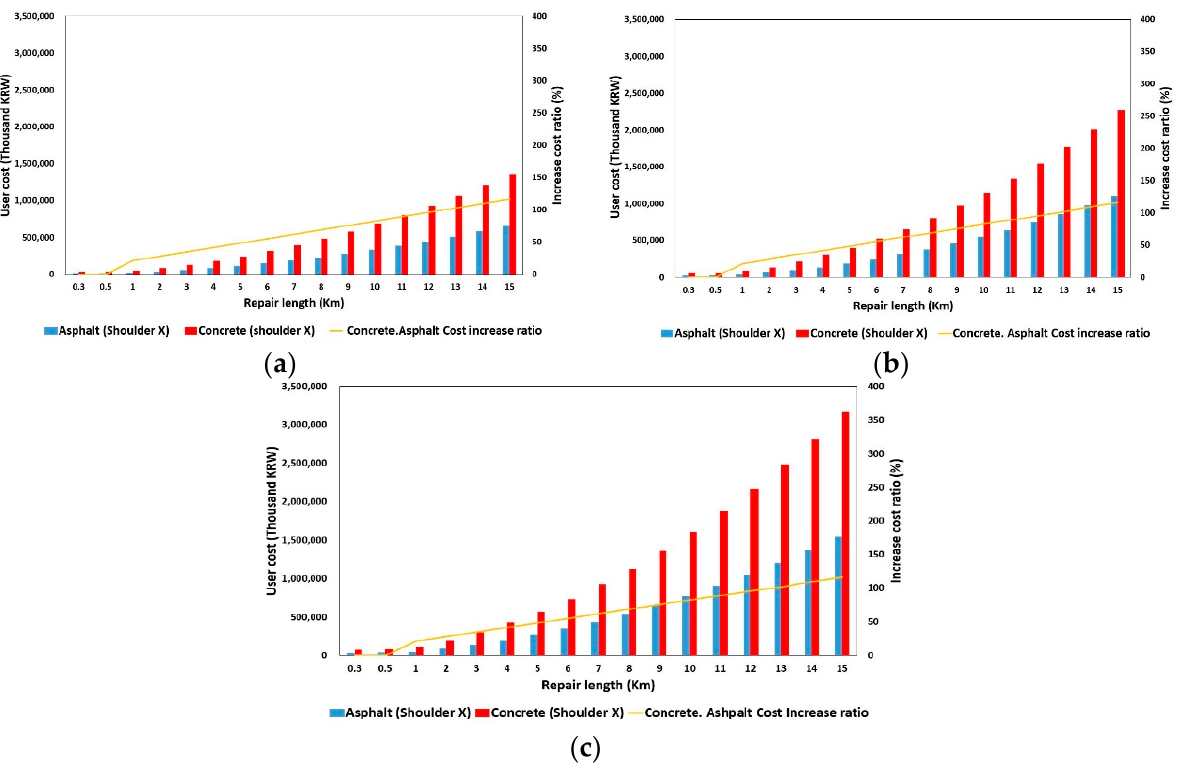
Figure 4. User cost comparison (Shoulder X, 11,000 AADT). ( a ) 15,000 AADT user cost (Shoulder X). ( b ) 25,000 AADT user cost (Shoulder X). ( c ) 35,000 AADT user cost (Shoulder X).